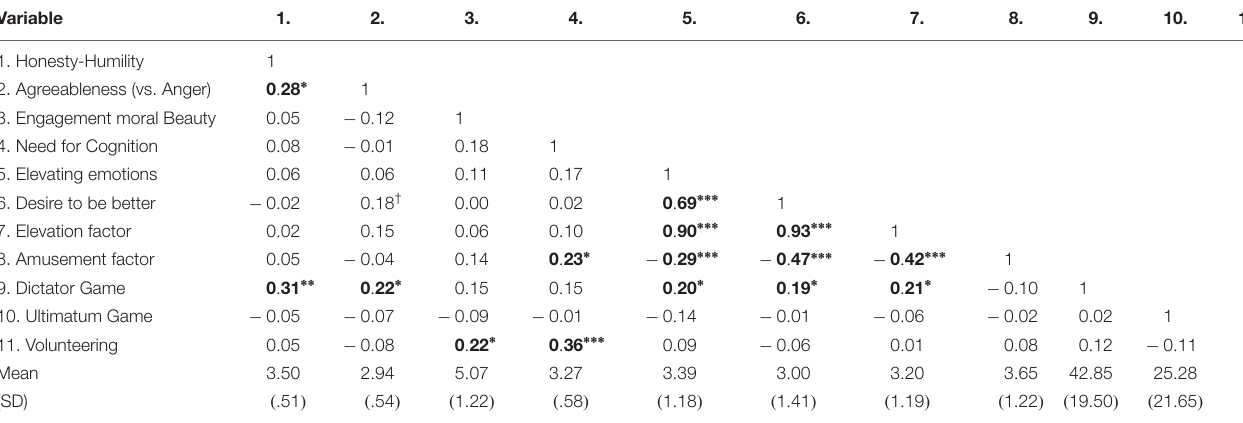
TABLE 1 | Means (standard deviations in parenthesis) and bivariate correlations of all variables.